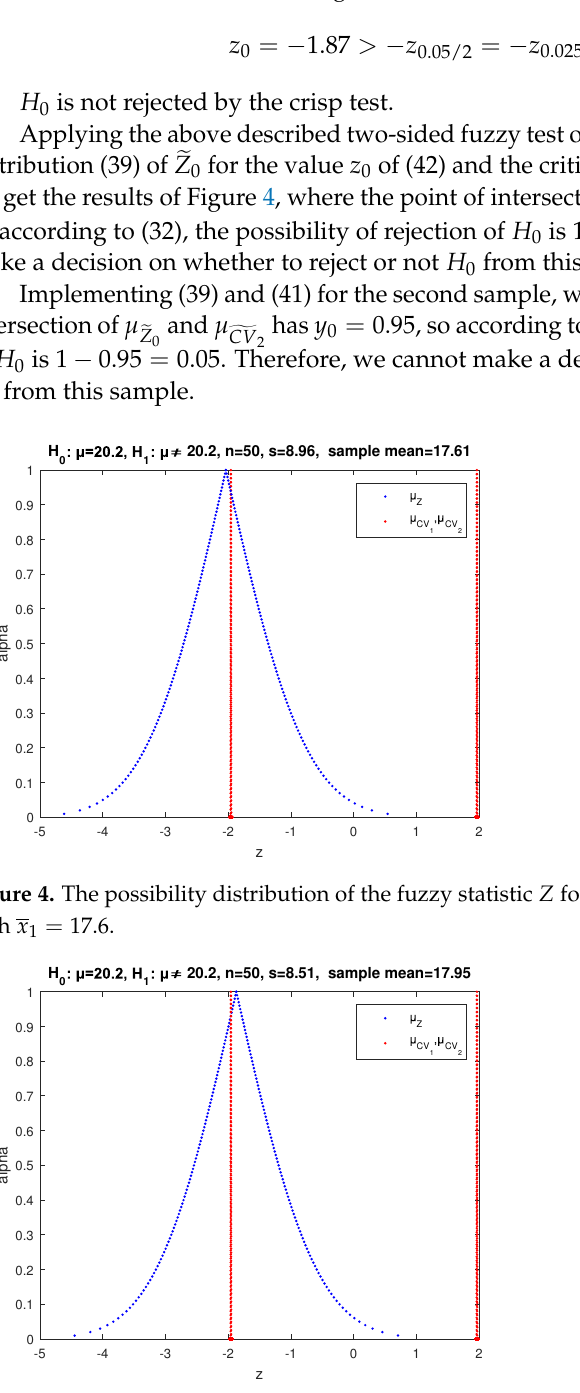
Figure 5. The possibility distribution of the fuzzy statistic Z for the test of Example 1 from a sample with x 2 =